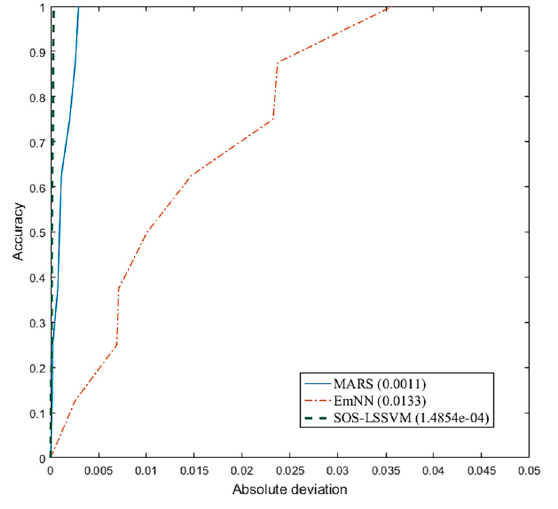
Figure 3. REC curve.